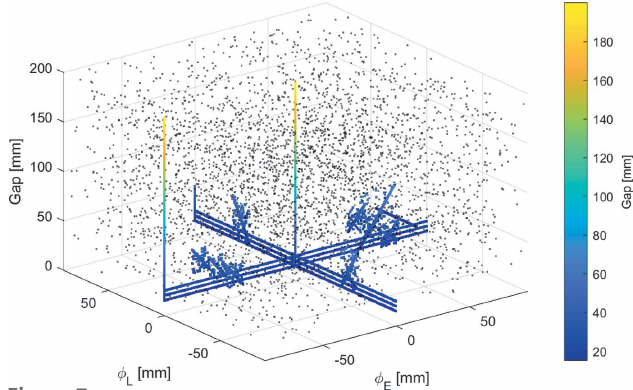
Figure 7 Total distribution of simulated data. The randomly generated cases are represented as black points to distinguish them from the initial 4175 cases.